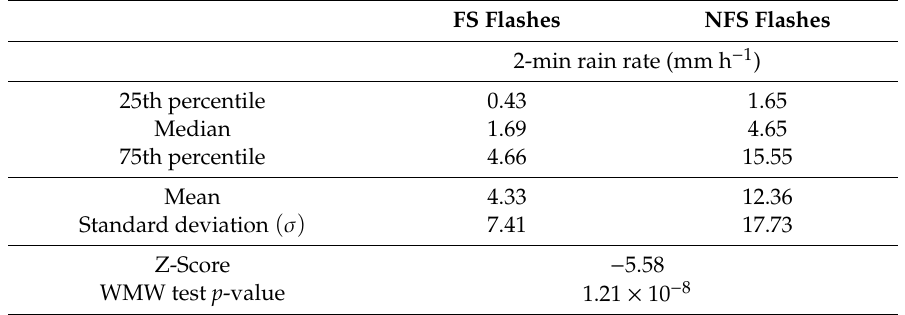
Table A1. Statistics of 2-min rain rate at the closest MRMS time for each FS and NFS flash.